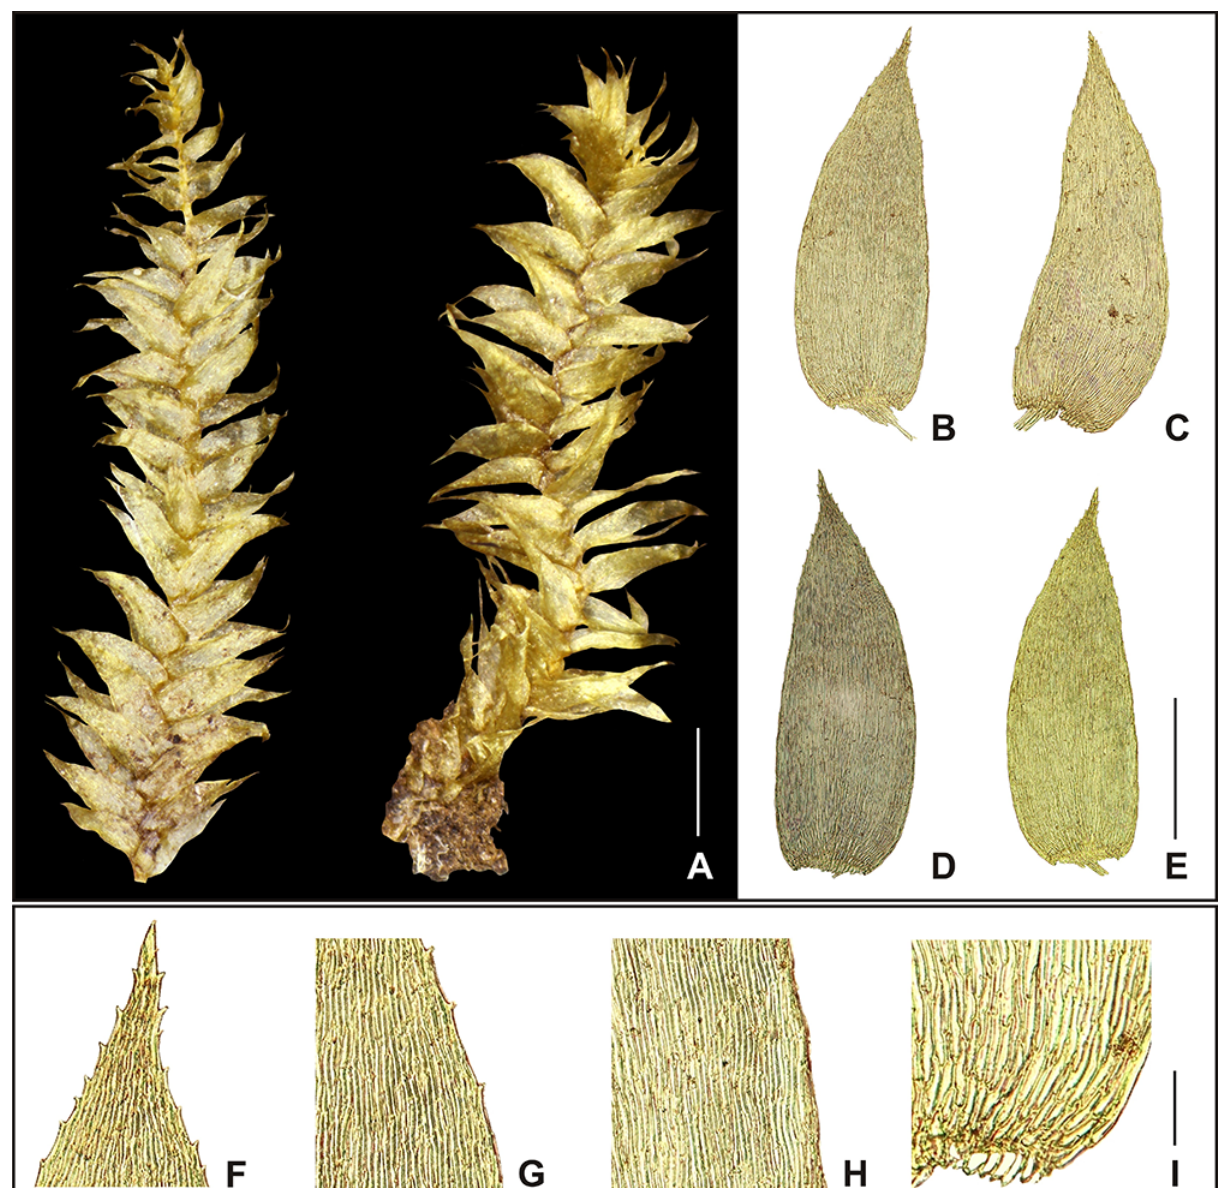
Figure 1 Pseudotaxiphyllum elegans . ( A ) Habit. ( B–E ) Leaves. ( F ) Leaf apex. ( G ) Distal leaf cells and margin. ( H ) Mid-leaf cells and margin. ( I ) Basal and angular leaf cells. A–C and F–I from Christophersen 2193 (FH-Bartram, paratype of Isopterygium tristaniense ), D–E from Christophersen 1377 (FH-Bartram, lectotype of Isopterygium tristaniense ). Scale bars: ( A ) 1 mm; ( B–E ) 0.5 mm; ( F–I ) 100 µ